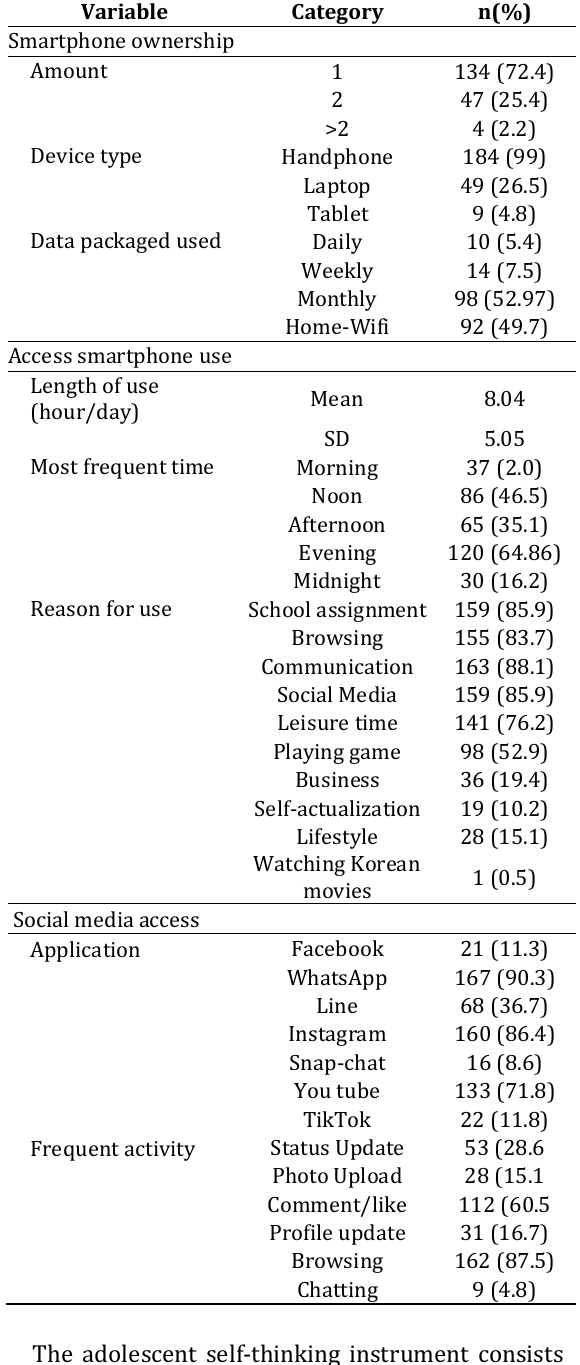
Table 3. Distribution of Technology’s Factor